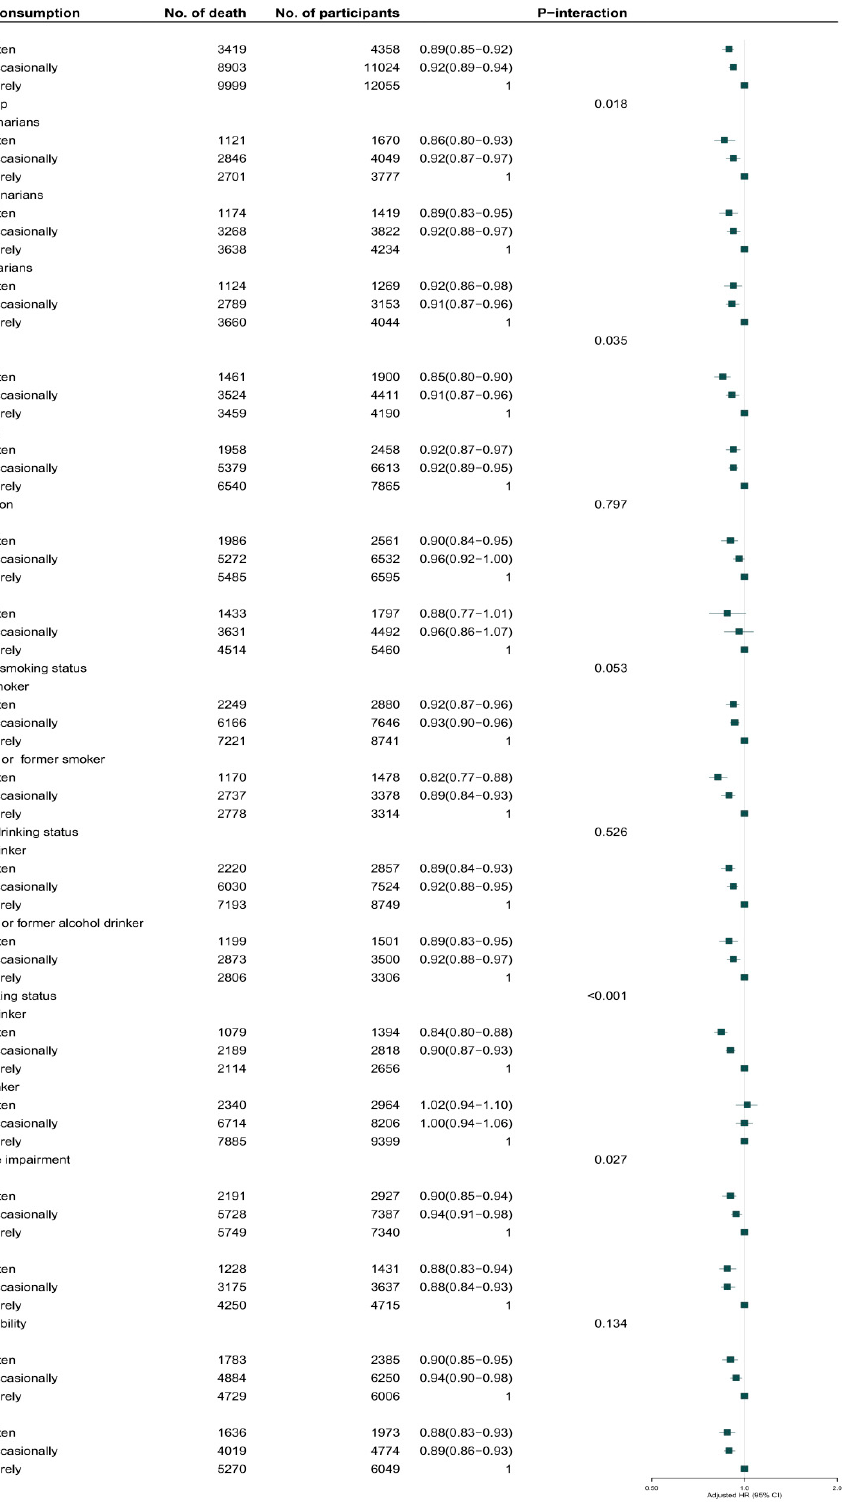
Figure 2. Association of garlic consumption at baseline with all-cause mortality in the oldest old. Adjusted for age, sex, BMI, residence, educational background, occupation, current marital status, living pattern, tobacco smoking, alcohol drinking, regular exercise, eating vegetables, eating fruits, meat, and fish, drinking tea, hypertension, heart disease, cerebrovascular disease, respiratory disease, cognitive impairment, and ADL disability.